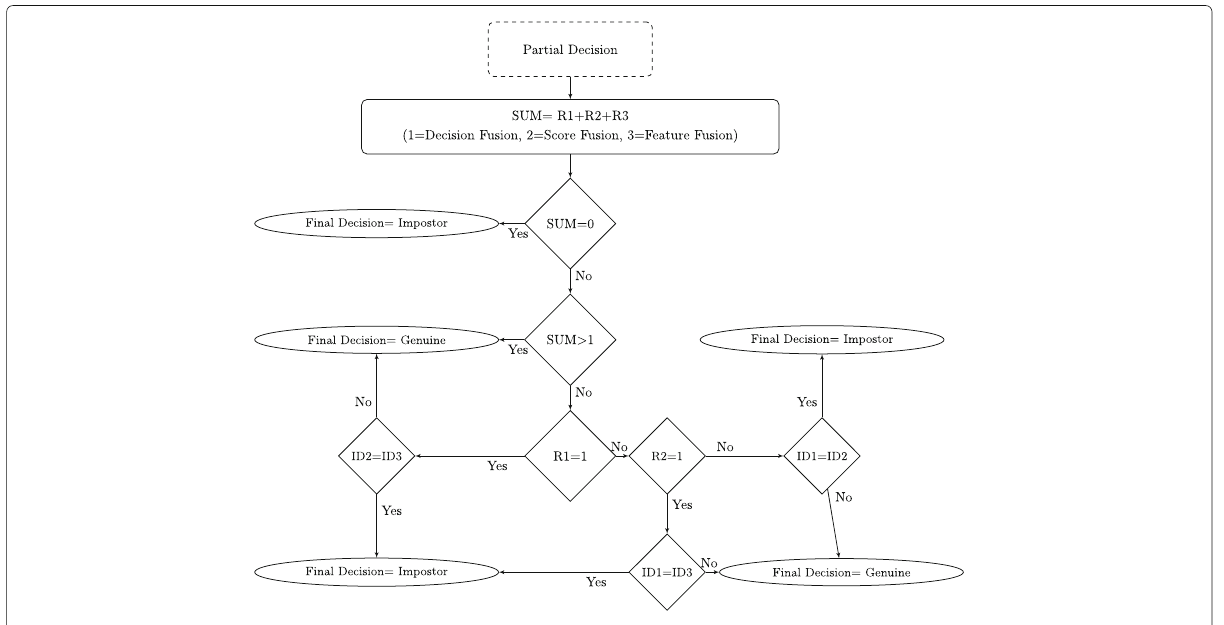
Fig. 2 The second decision-level of the proposed method